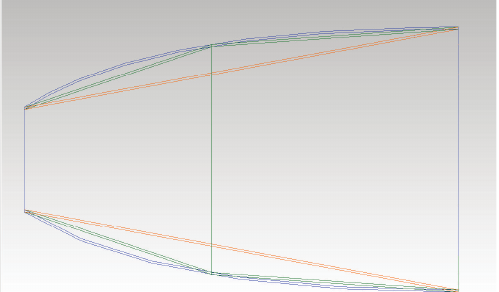
Figure 1: Ideal CPC (blue), 1-cone (orange) and 2-cone (green) point-approximated CPCs.